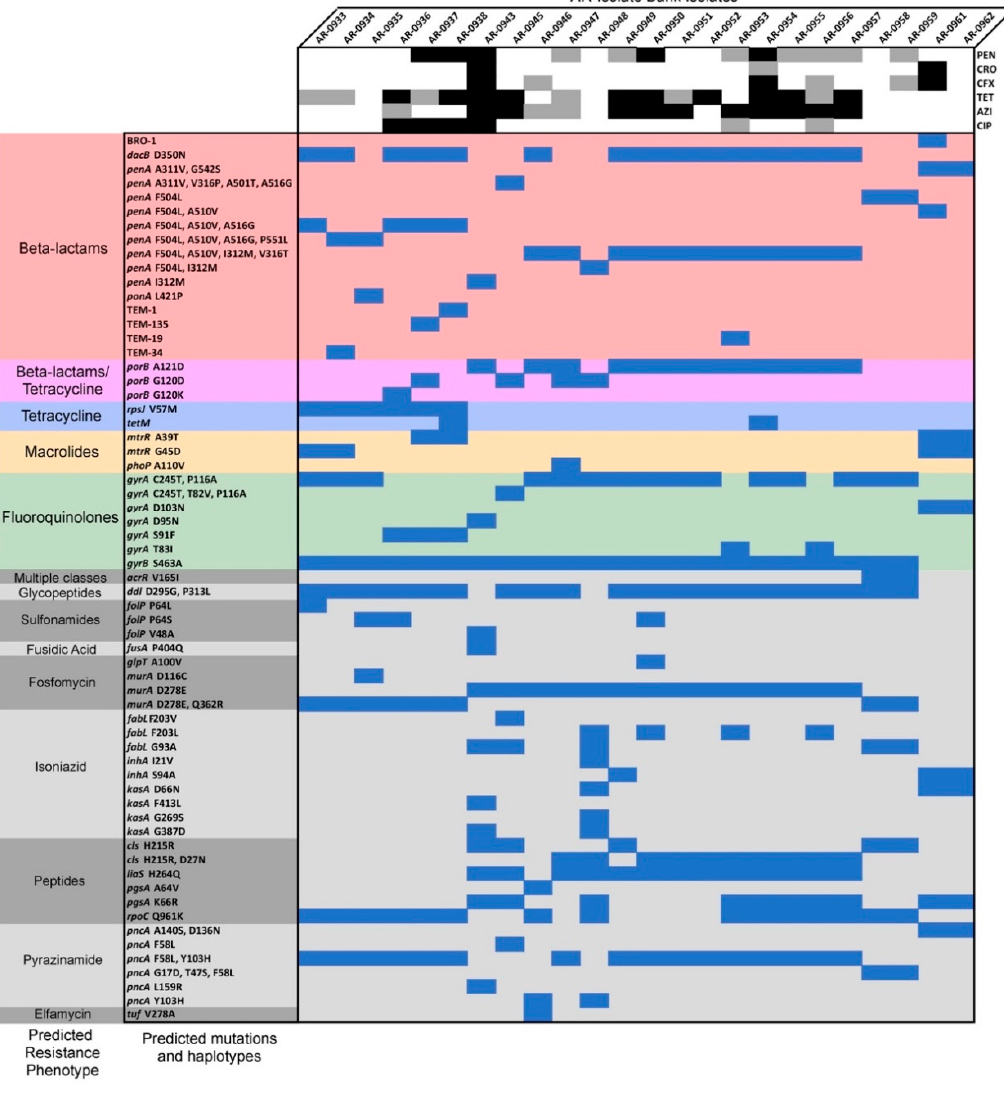
Figure 2. Heatmap showing the distribution of Comprehensive Antibiotic Resistance Database (CARD) Resistance Gene Identifier (RGI) predicted resistance-encoding mutations for all sequenced isolates ( n = 24). Upper panel: Neisseria species’ susceptibility phenotypes as quantified by MIC. Black denotes loss of susceptibility (CLSI standards), grey denotes one dilution below the reduced susceptibility breakpoint, and white denotes susceptibility to the antibiotics listed on the right (PEN, penicillin; CRO, ceftriaxone; CFX, cefixime; TET, tetracycline; AZI, azithromycin; and CIP, ciprofloxacin). Lower panel: presence of each recovered mutation is indicated by blue fill. CARD-predicted resistance phenotypes for sets of mutations are denoted for beta-lactam resistance (red shading), beta-lactam and tetracycline resistance (purple), tetracycline (blue), macrolides (orange), fluoroquinolones (green), and resistance to other antibiotics (grey).